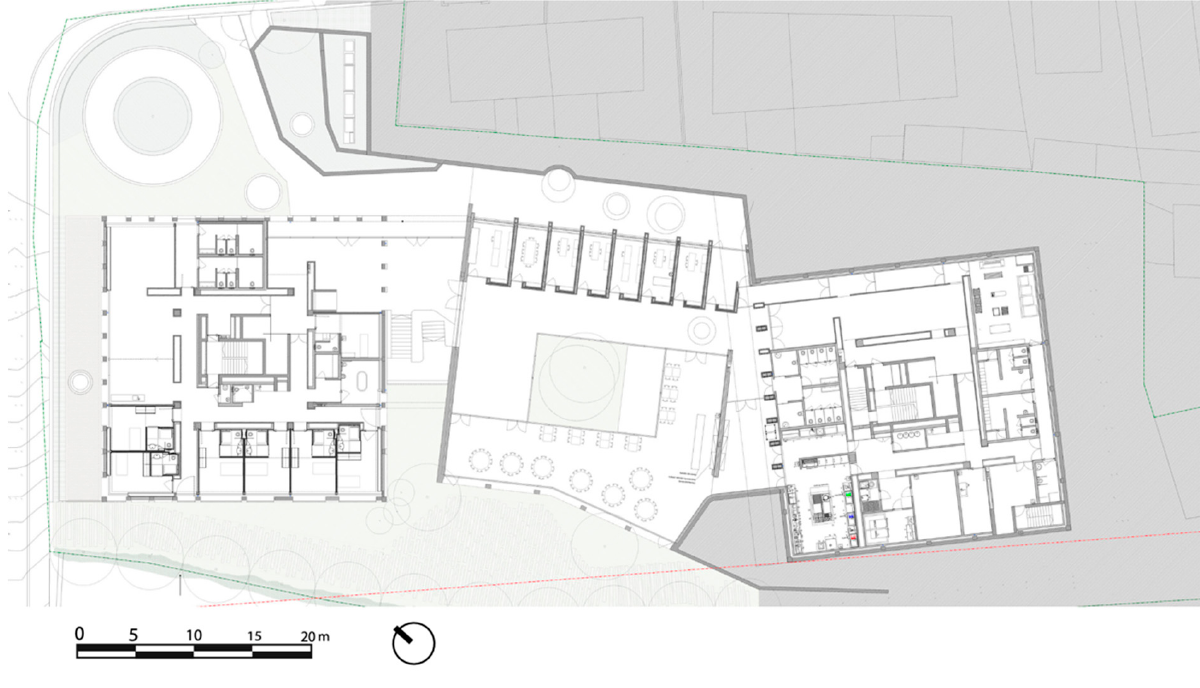
Figure 20. Vila Nova de Gaia. Ground-floor plan.